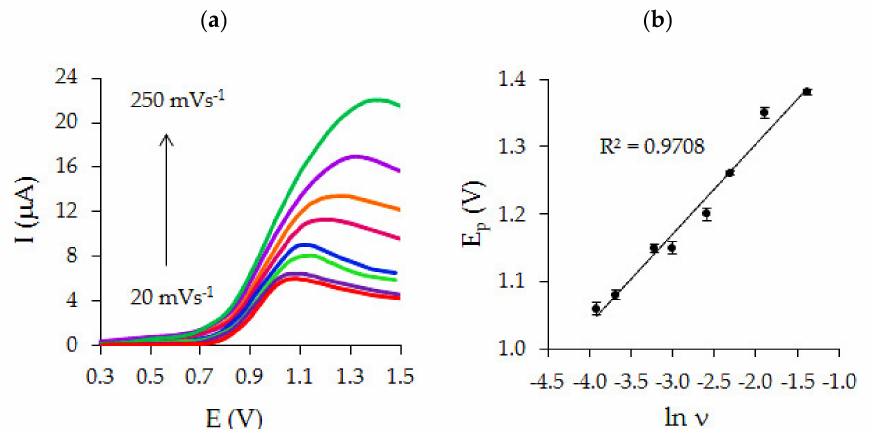
Figure 9. Linear sweep voltammograms of the TrX100 / FCVE in BRB (pH 3) containing 0.02 mM NO 2 −